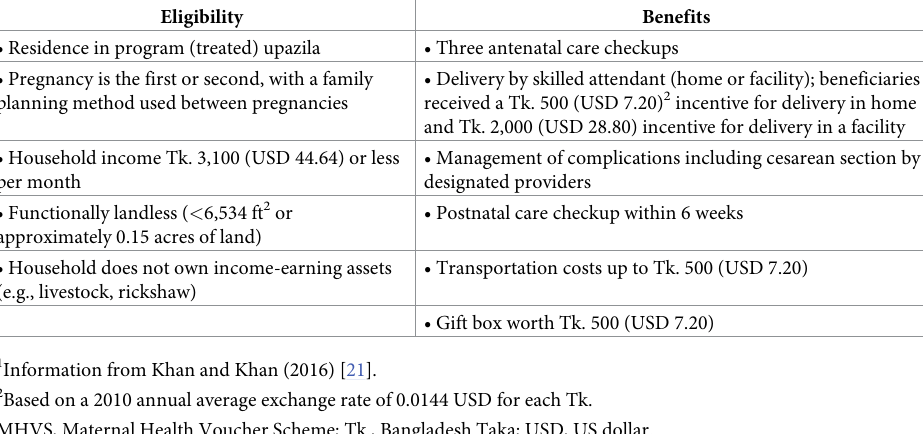
Table 1. Bangladesh MHVS eligibility criteria and benefits 1